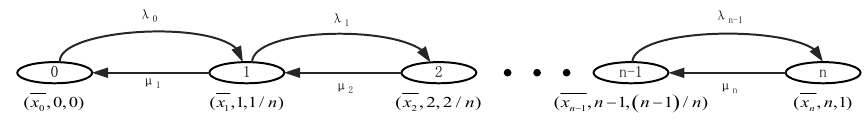
Figure 10. State transition diagram of coexisting WBANs under m-tolerated channel conflict